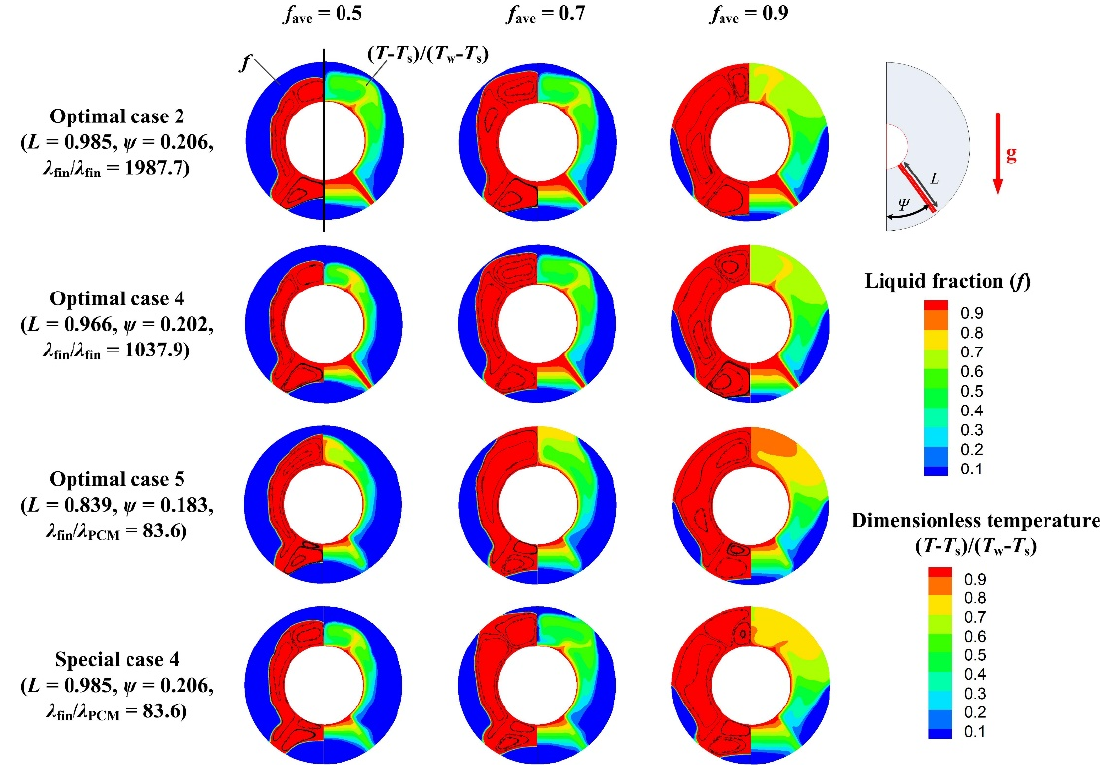
Figure 10. Contour maps of liquid fraction and dimensionless temperature for Optimal Cases 2, 4 and 5 and Special Case 4.